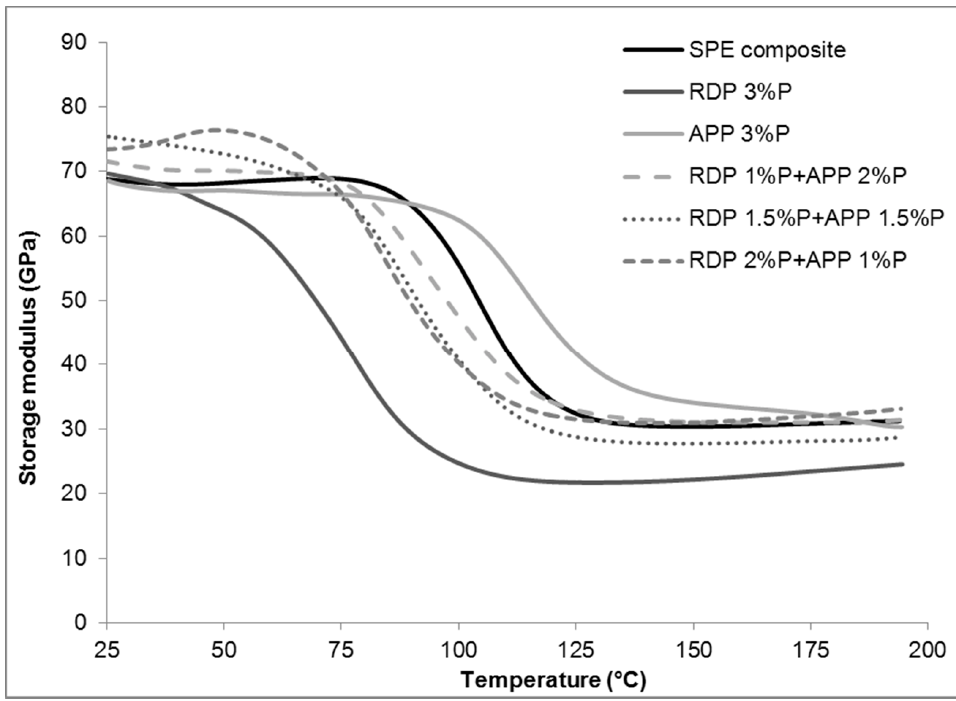
Figure 6. Storage modulus curves of reference and flame retarded SPE composites. Table 4. Storage moduli of reference and flame retarded SPE composites. Flame Retardant Composition Storage Modulus at 25 ◦ C [GPa] Storage Modulus at 75 ◦ C [GPa] SPE composite